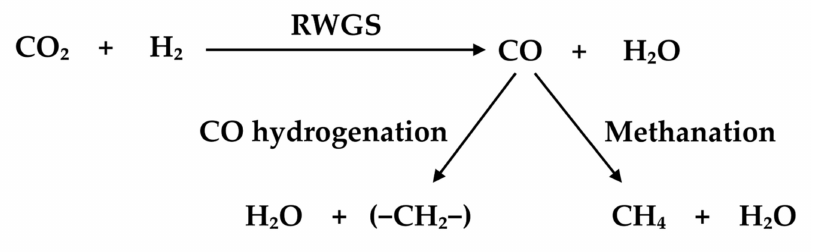
Figure 6. Illustration of the reaction pathway of CO 2 hydrogenation into hydrocarbon